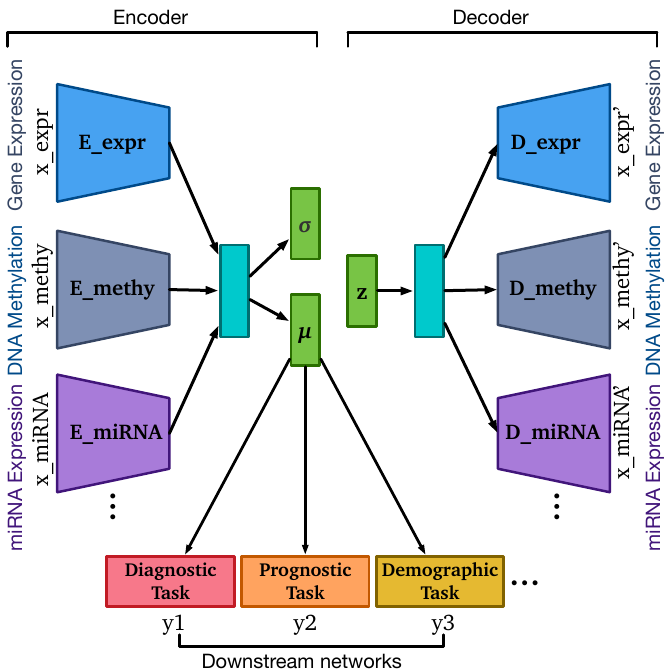
Figure 1. The overall architecture of OmiEmbed is comprised of two main components: the VAE deep embedding networks and the downstream task networks. The number of omics types and downstream tasks can be modified based on the user needs and requirements of the experiment. E_expr, E_methy and E_miRNA represent encoders of gene expression, DNA methylation and miRNA expression respectively. Similarly, D_expr, D_methy and D_miRNA represent decoders of gene expression, DNA methylation and miRNA expression. µ , σ and z represent the mean vector, the standard deviation vector and the latent vector calculated by the reparameterisation trick,